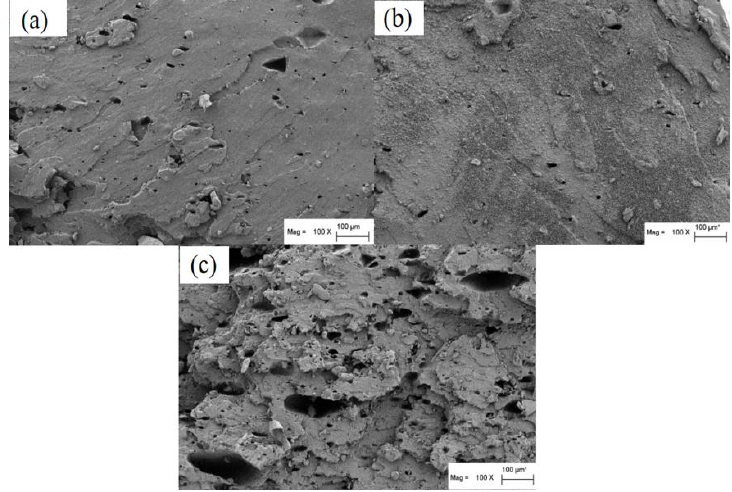
Figure 9. Scanning electronic microscopy (SEM) images of ( a ) NR/BR/KL10 at a lignin content of 10 phr, ( b ) NR/BR/HMKL at a lignin content of 10 phr, and ( c ) NR/BR/HMKL at a lignin content of 20 phr.